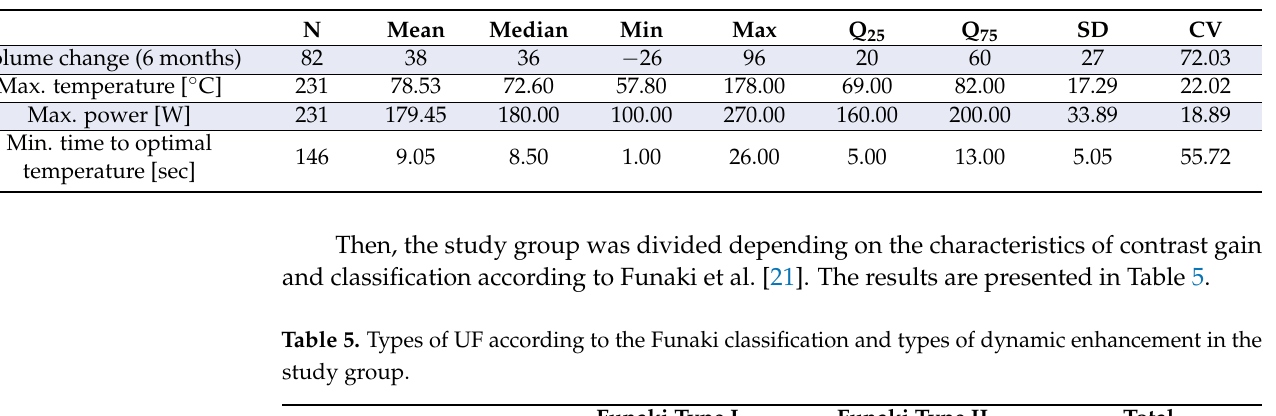
Table 4. Selected parameters of the procedure in the study group (single parameters are missed).